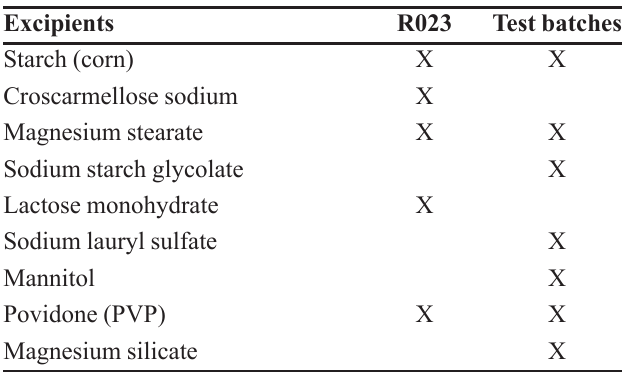
TABLE I - Excipients present in the reference medicine and